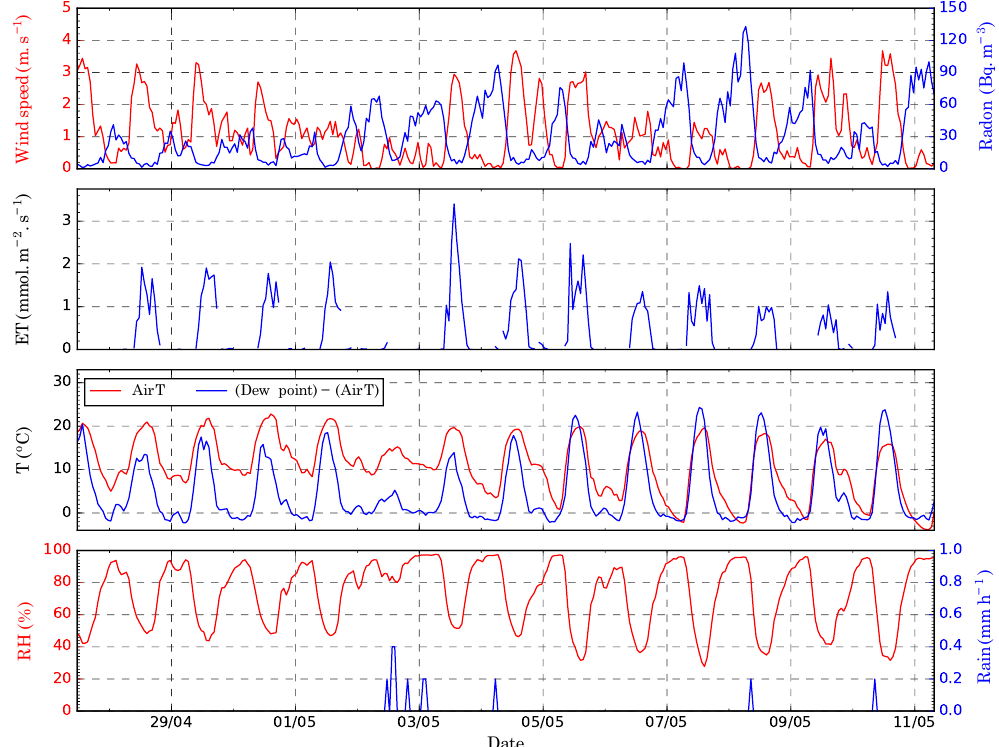
Figure 5. Meteorological and radon measurements collected throughout the field campaign. Meteorological measurements are block hourly averages calculated from 15min observations. Small rain events on 4, 8 and 10 May were most likely dewfall rather than precipitation.